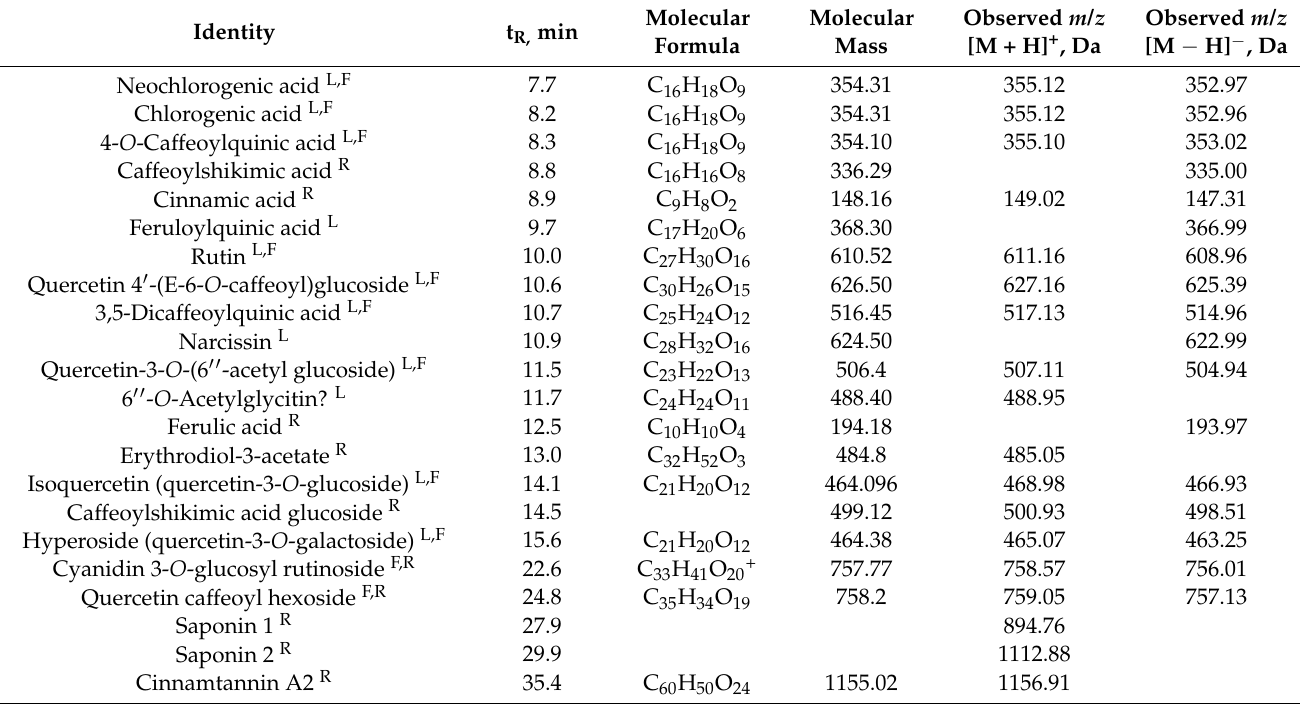
Table 3. Tentative identification of main compounds in methanol/water (MeOH:H 2 O, 70:30 v/v ) Solidago canadensis inflorescence, leaf and root extracts analyzed by HPLC-DAD-TOF.